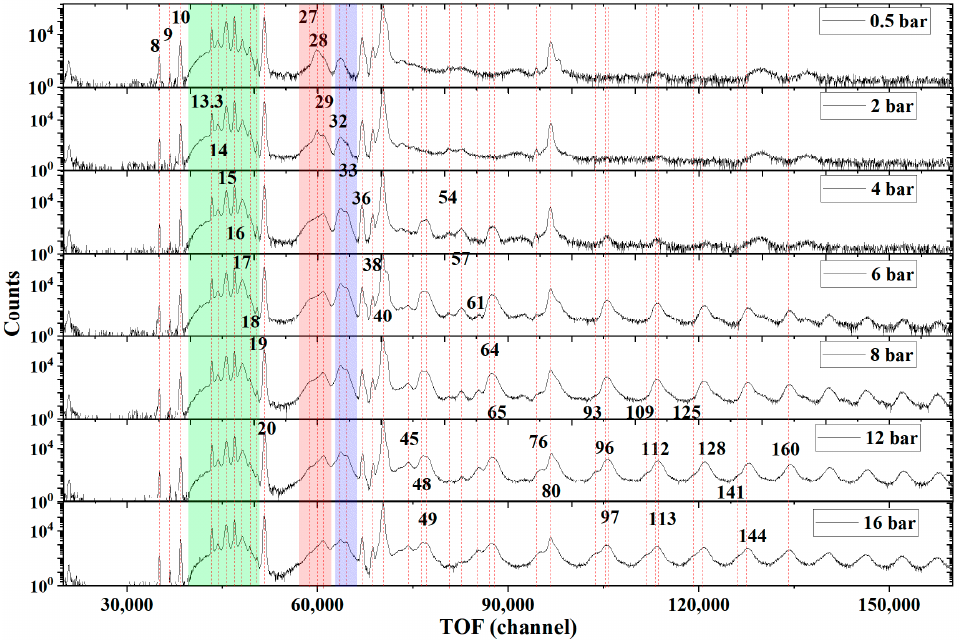
Figure 1. The 1D TOF spectrum of the ions after electron impact ionization as the stagnation pressure varies from 0.5 bar to 16 bar. The green rectangle shows the broad TOF distribution induced by the Coulomb explosion of the CH 4 ion; the red and blue rectangles indicate TOF distributions of the C 2 H m+ ion and CH 4 CH 5+ ions, respectively; the dotted lines denote the m / z of each ion.